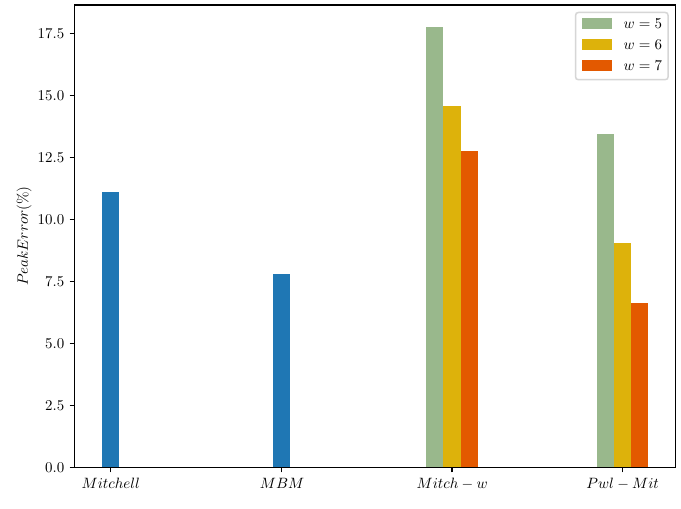
Figure 7. Peak error comparison. Table 2. Design metrics comparison for proposed Pwl-Mit